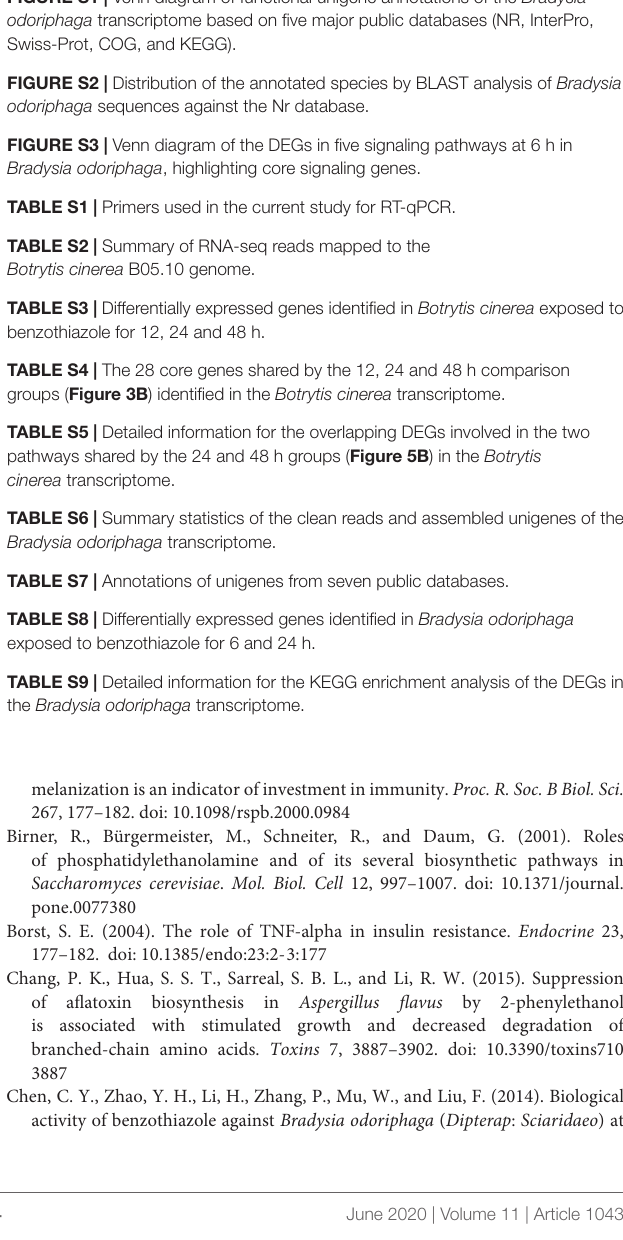
FIGURE S1 | Venn diagram of functional unigene annotations of the Bradysia odoriphaga transcriptome based on five major public databases (NR, InterPro, Swiss-Prot, COG, and KEGG).